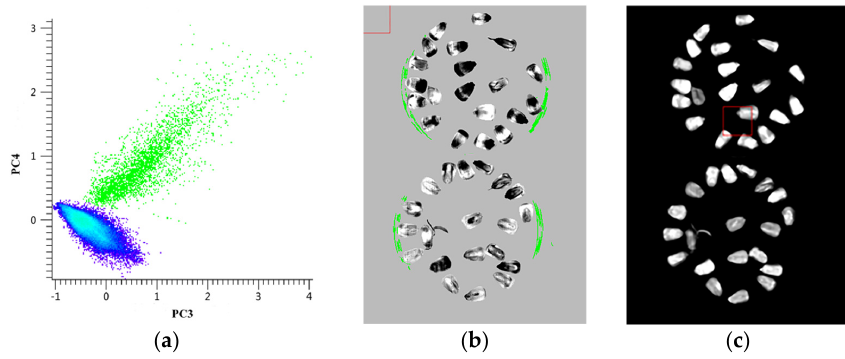
Figure 2. ( a ) PCA scatter plot of PC 3 vs. PC 4 (0.92% and 0.2%) of the masked image of D 7 ; ( b ) corresponding score image where the green class represented the Petri dishes; and ( c ) a clean image.